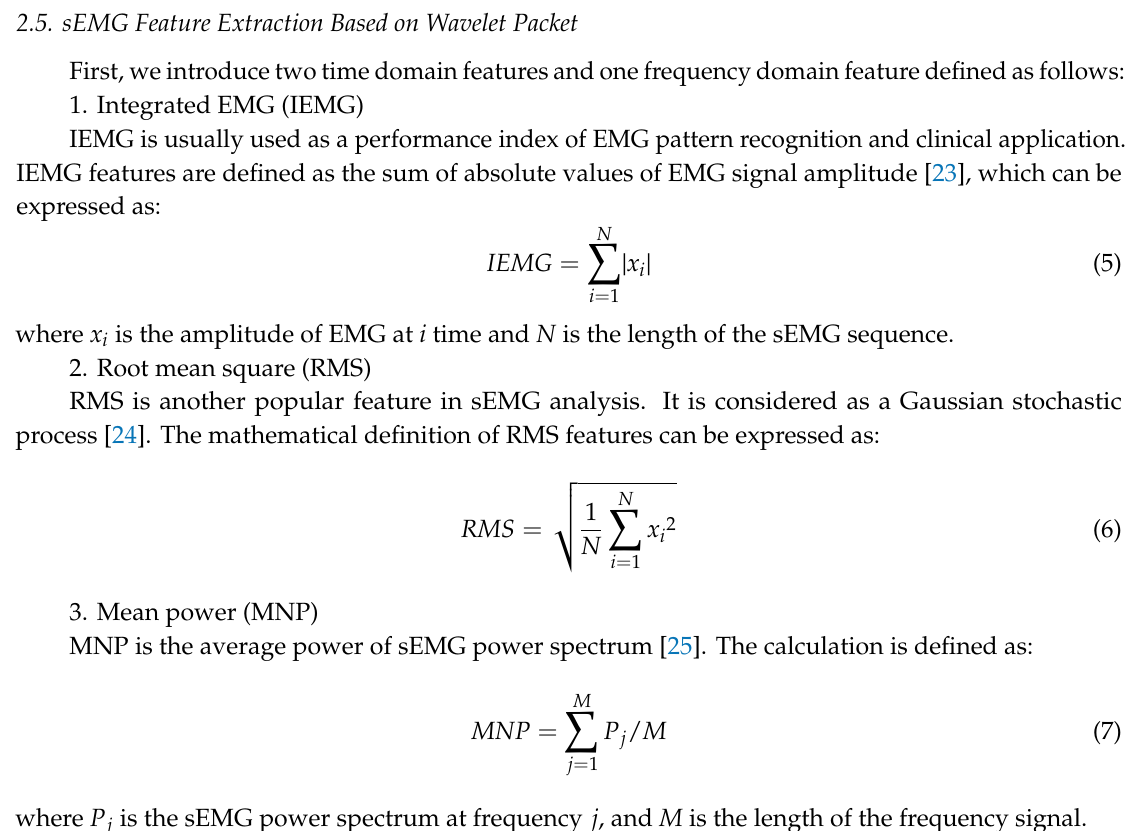
Figure 12. Comparison diagram of ( a ) original signal and ( b ) denoised signal.